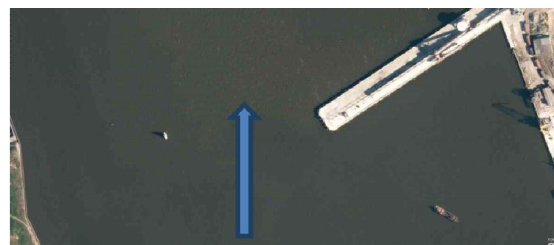
Fig. 4. Quay walls 66A and 67A located at an angle of 70–80° to the current at the Port of Klaipėda